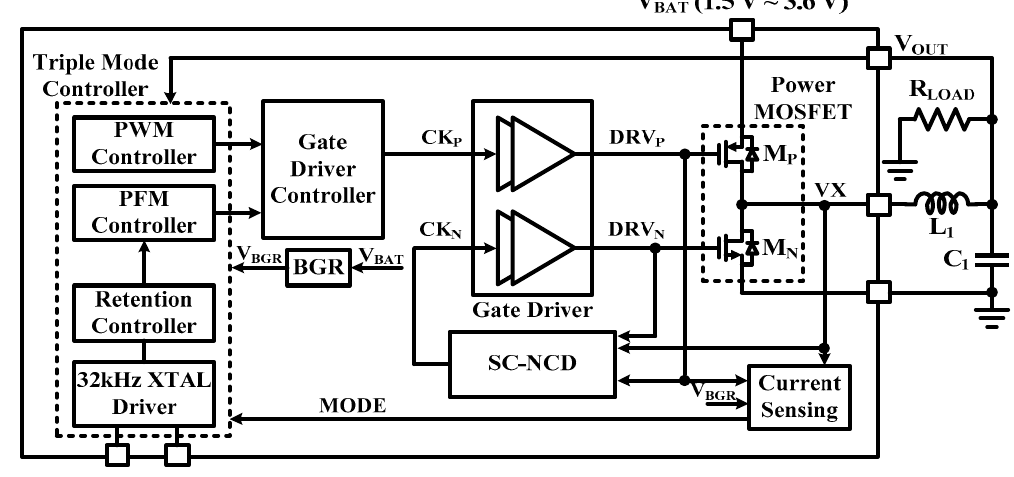
Figure 15. Block diagram of the DC-DC buck converter in triple-mode.